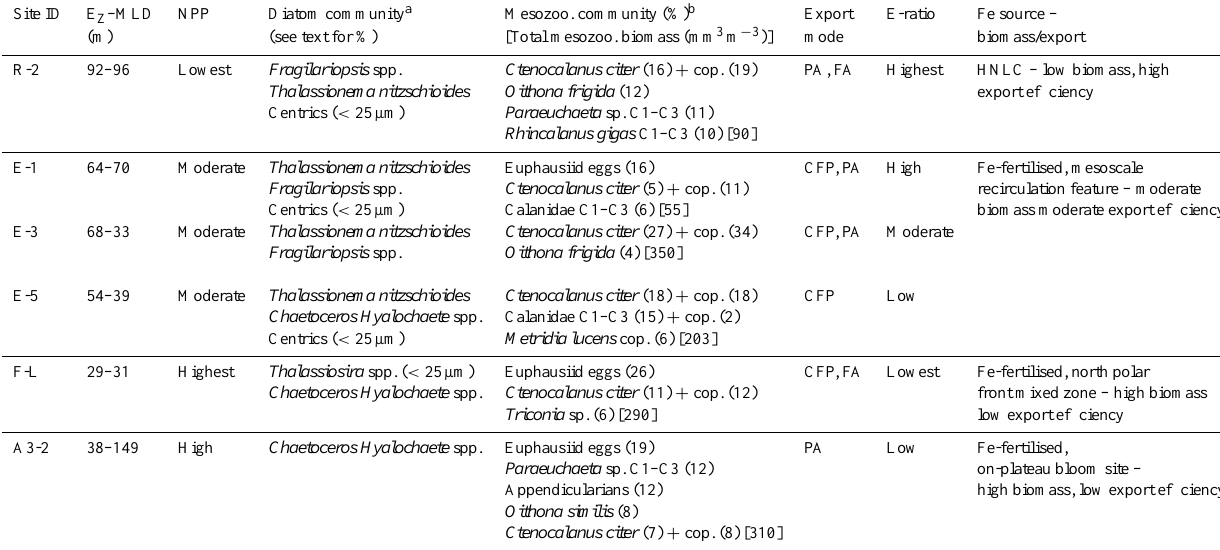
Table 6. Summary of site characteristics based on their primary productivity, plankton communities, iron-fertilisation and carbon export